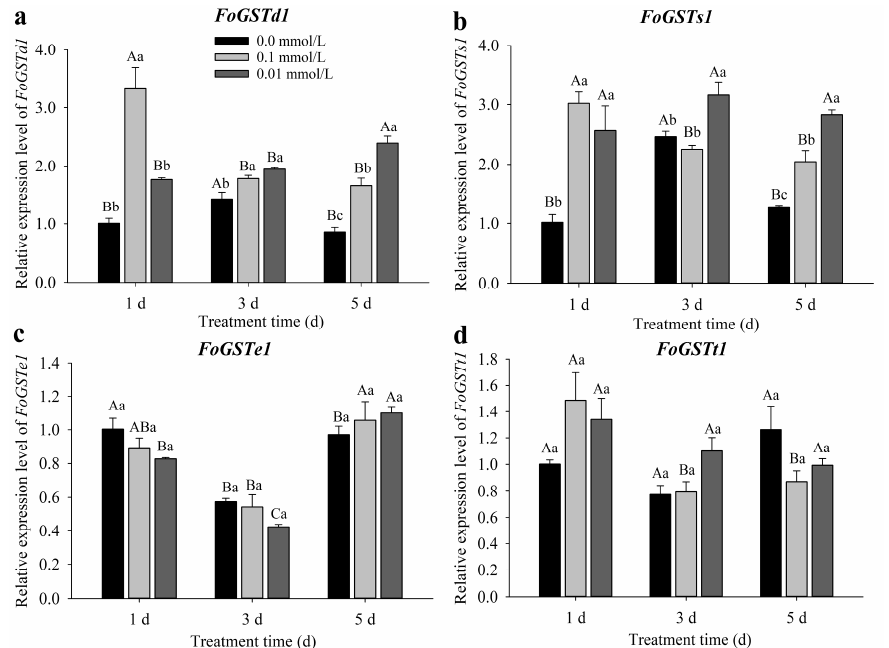
Figure 1. Relative expression levels of FoGSTd1 , FoGSTs1 , FoGSTe1 , and FoGSTt1 in second-instar larvae of Frankliniella occidentalis after feeding on exogenous jasmonic acid (JA)-induced kidney bean leaves. ( a ) Relative expression levels of FoGSTd1 ; ( b ) Relative expression levels of FoGSTs1 ; ( c ) Relative expression levels of FoGSTe1 ; ( d ) Relative expression levels of FoGSTt1 . All data are the mean ± standard error (SE). Different uppercase letters above bars indicate significant differences in expression levels among different periods of the same treatment, whereas different lowercase letters indicate significant differences among different treatments at the same time ( p < 0.05; one-way ANOVA, followed by Tukey’s